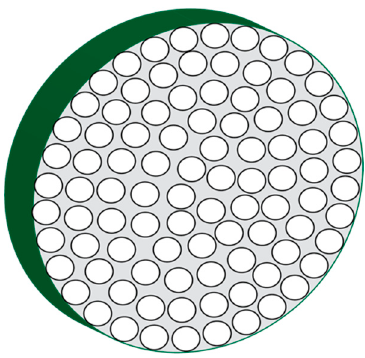
Figure 1. Cartoon representation of a high-magnification transverse cross-section through a developing sea urchin spicule, revealing radial, coaxially arranged calcium carbonate mineral nanoparticles. Adapted from references [21,27].